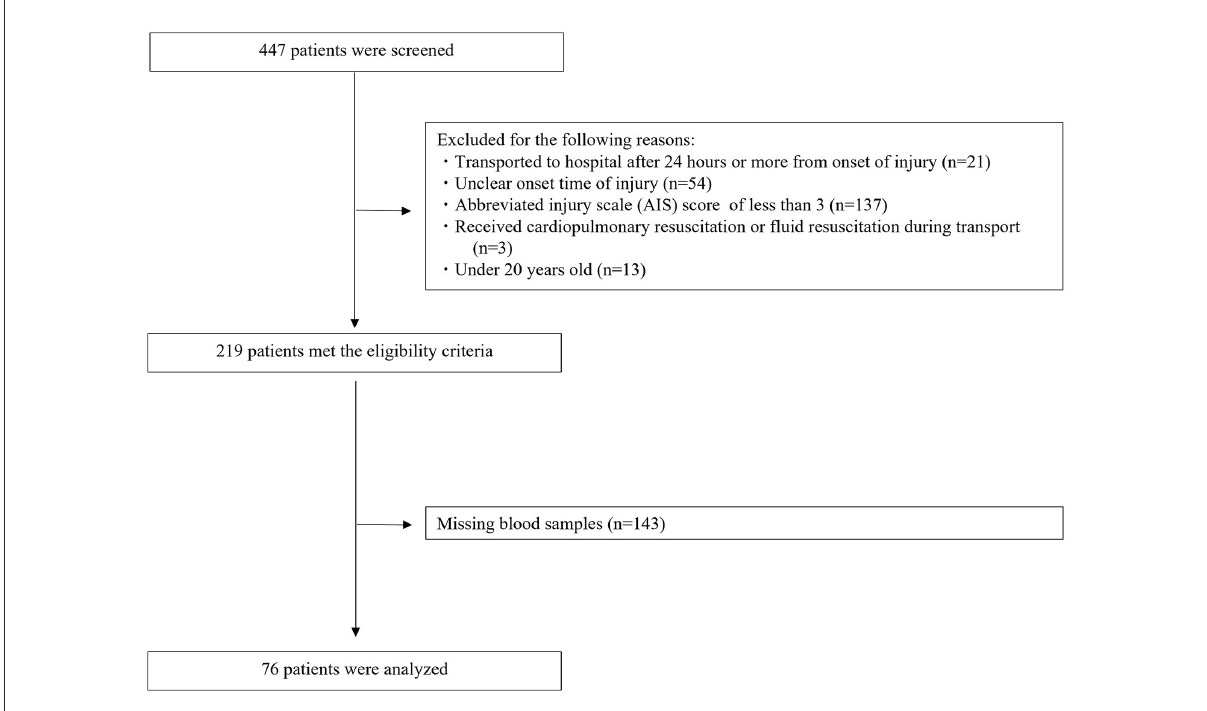
FIGURE1 CONSORT